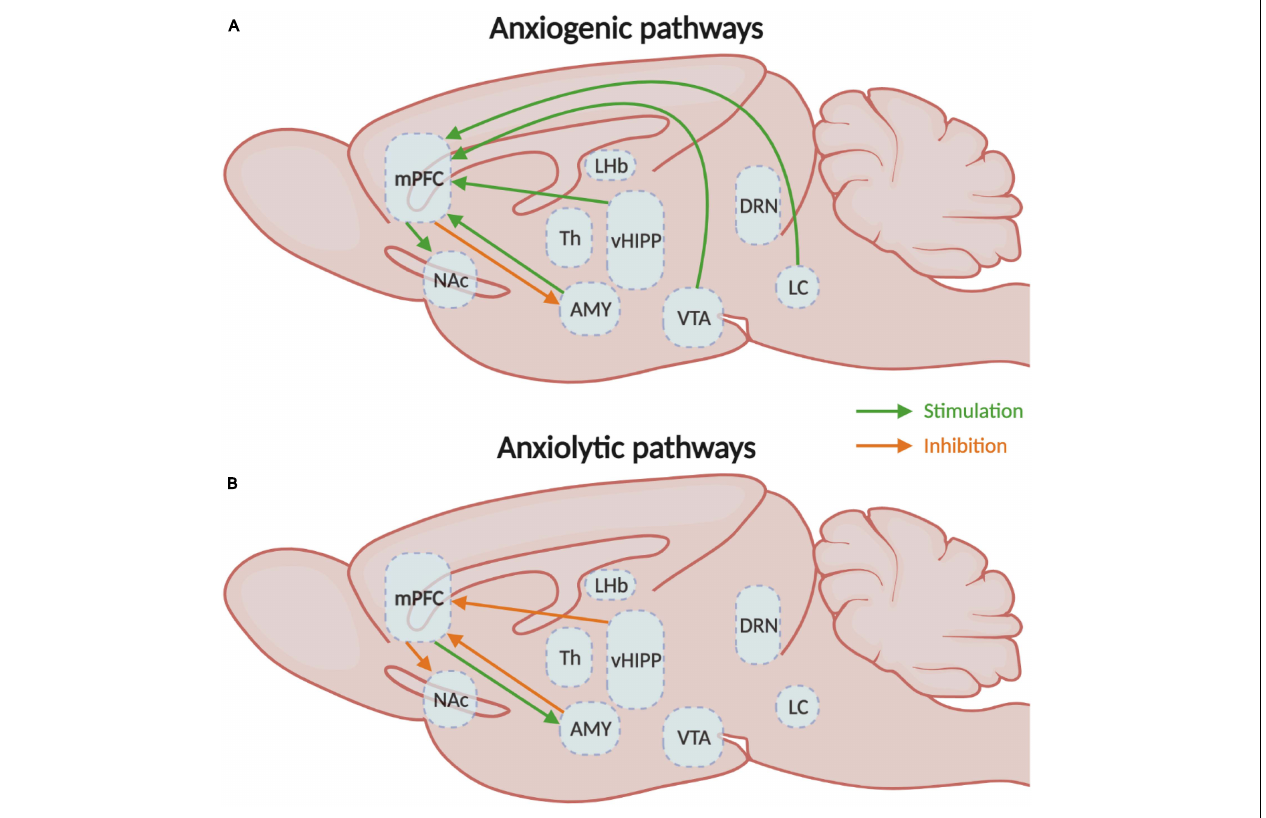
FIGURE 3 | Medial prefrontal circuitry involved in anxiety-like behaviors. (A) Schematic representation of the mPFC circuits involved in the expression of either (A) anxiogenic or (B) anxiolytic behavioral responses. mPFC, medial prefrontal cortex; NAc, nucleus accumbens; Th, thalamus; vHIPP, ventral hippocampus; VTA, ventral tegmental